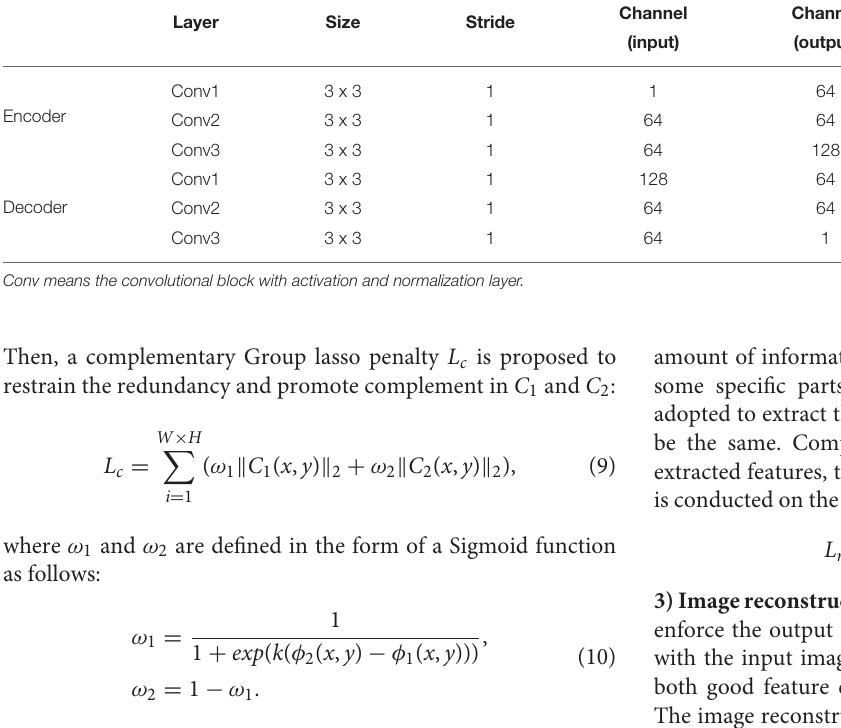
TABLE 1 | The architecture of encoder and decoder. Layer Size Stride Channel Channel Activation Normalization